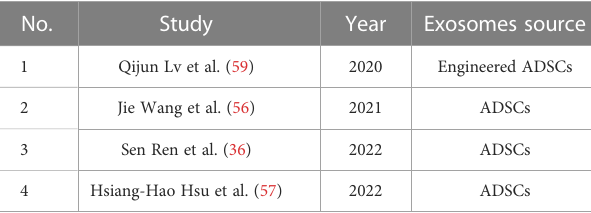
TABLE 3 MSCs-exo in accelerating re-epithelialization and collagen deposition.